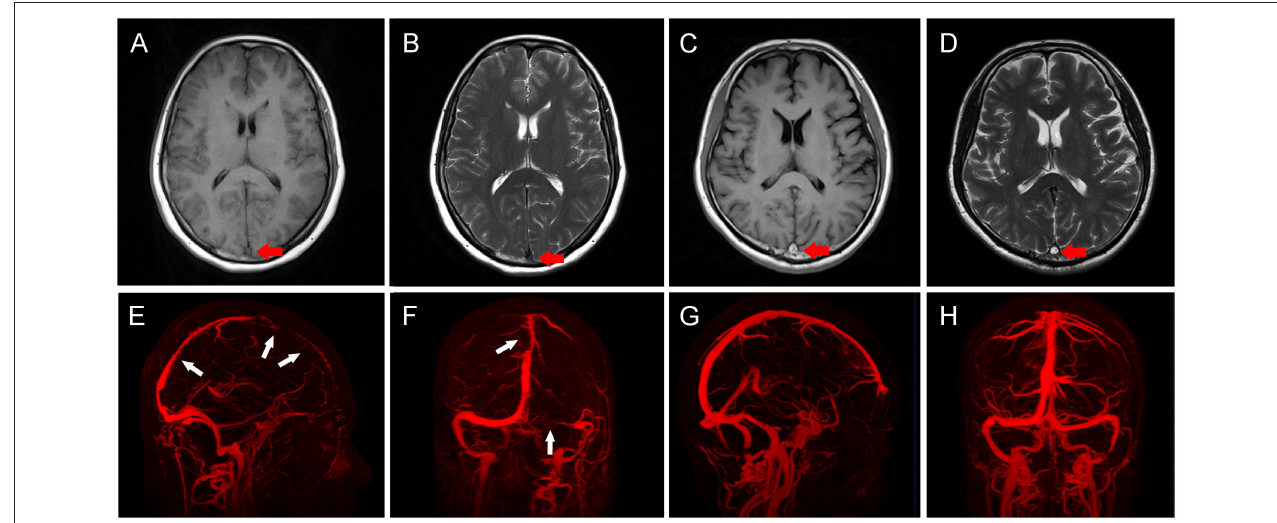
FIGURE 1 | Imaging characteristics of patients with cerebral venous sinus thrombosis (CVST). (A,B) In acute CVST patients, clots showed near-normal signal (red arrow) on T1WI (A), and unusual frank hypointensity (red arrow) on T2WI (B) . (C,D) In subacute CVST patients, clots showed clear hyperintensity (red arrows) on both T1WI (C) and T2WI (D) . (E,F) Three-dimensional reconstruction of MRV in CVST patients. The sagittal view (E) showed multiple filling defects in SSS (white arrows), coronal view (F) showed filling defects (white arrow) in SSS, and the right transverse sinus was not visualized (white arrow). (G,H) Three-dimensional reconstruction of MRV in normal subjects. The sagittal (G) and coronal (H) views show continuous vessels without filling